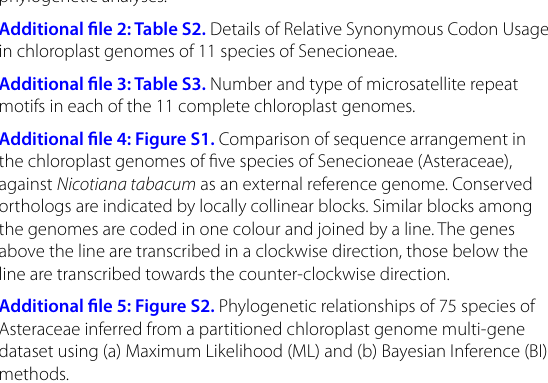
Additional file 5: Figure S2. Phylogenetic relationships of 75 species of Asteraceae inferred from a partitioned chloroplast genome multi-gene dataset using (a) Maximum Likelihood (ML) and (b) Bayesian Inference (BI)